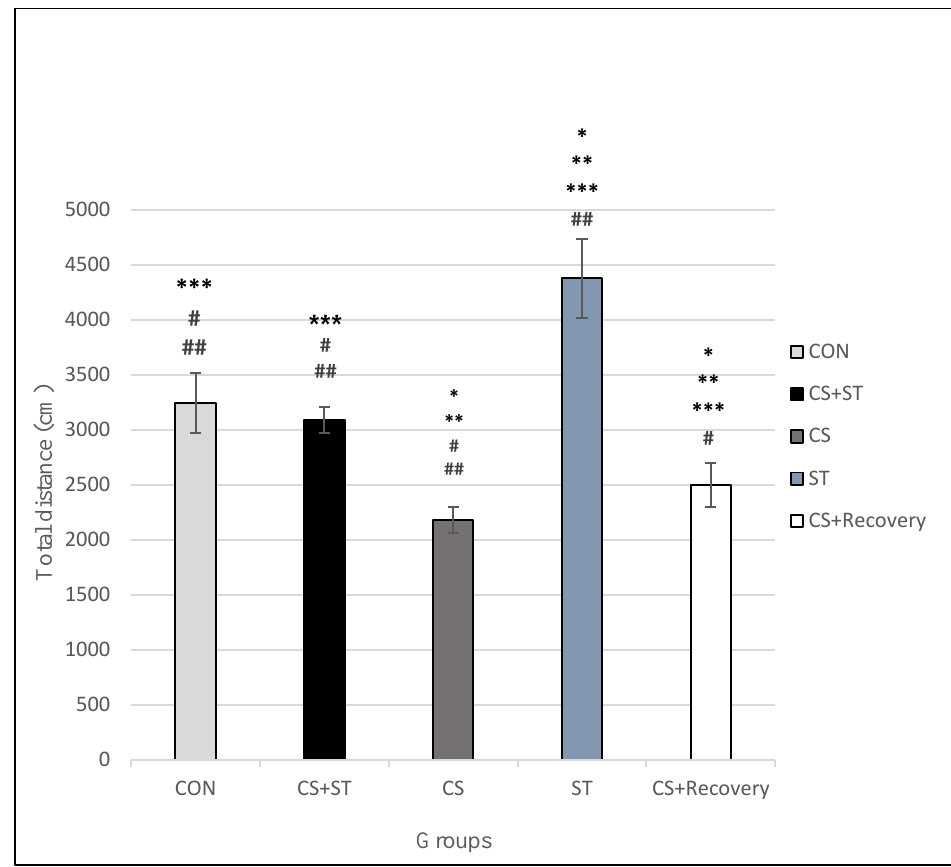
Figure 3. Total distance (cm) in male rats. Data are expressed as the mean ± S.E.M. * p < 0.00,1 significantly different from the control group. ** p < 0.001, significantly different from the CS + ST group. *** p < 0.001, significantly different from the CS group. # p < 0.001, significantly different from the ST group. ## p < 0.001, significantly different from the CS + Recovery group. CS + ST: chronic mild stress followed by swimming training, CS: chronic mild stress, ST: swimming training, CS + Recovery: chronic mild stress followed by recovery time, CON: control.